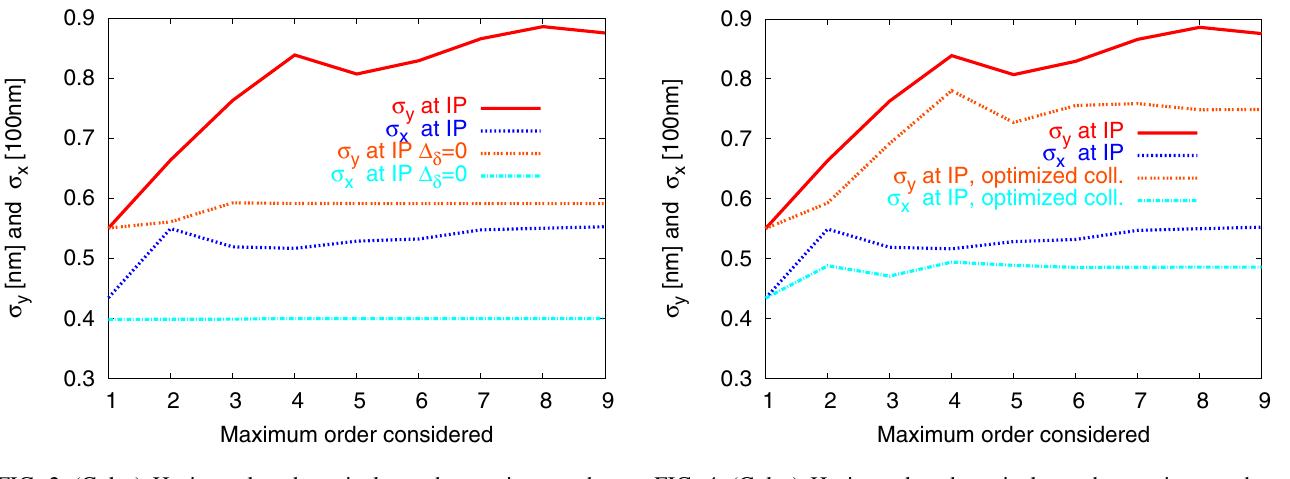
FIG. 4. (Color) Horizontal and vertical rms beam sizes at the CLIC IP for the nominal collimation system and the one with optimized chromaticity.